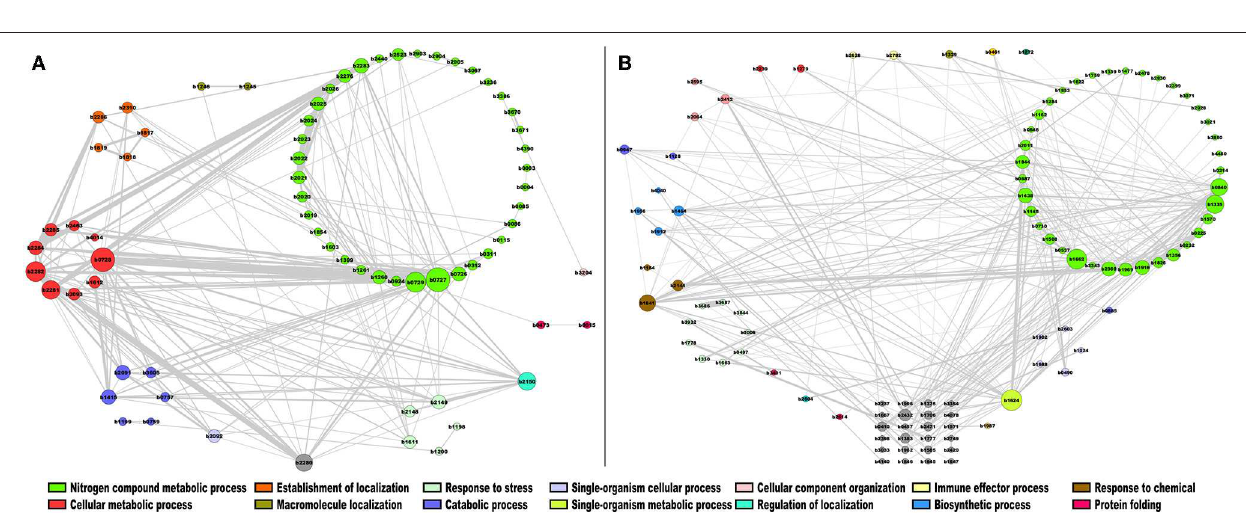
FIGURE 7 | Co-expression network of E. coli . The most highly correlated genes were plotted in Cytoscape (Smoot et al., 2010). The sizes of the modules correspond to their degrees of connectivity, while the widths of the edges represent the weights of the correlations, gray nodes do not have an assigned function. (A) TFs; (B) metabolism